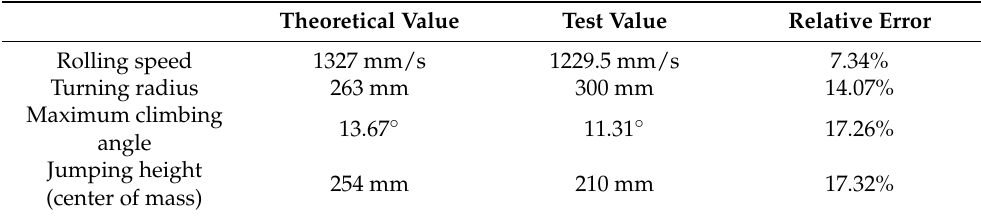
Table 3. Key motion characteristics of the theoretical model and